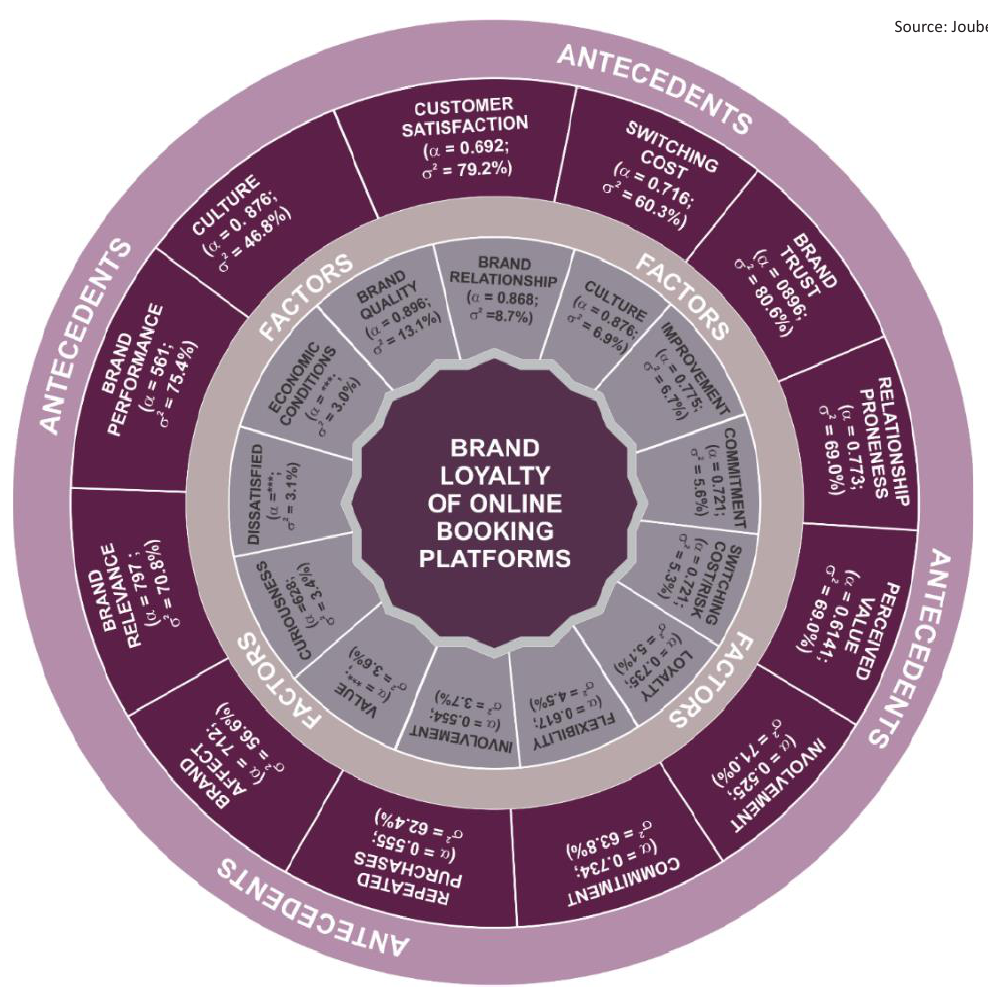
Figure 3. Integrated model to measure brand loyalty in the online booking platform industry